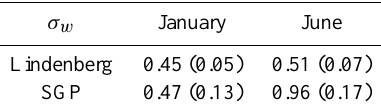
Table 1. Typical σ w for the observations (AROME) in m s − 1 at Lindenberg and SGP in January and